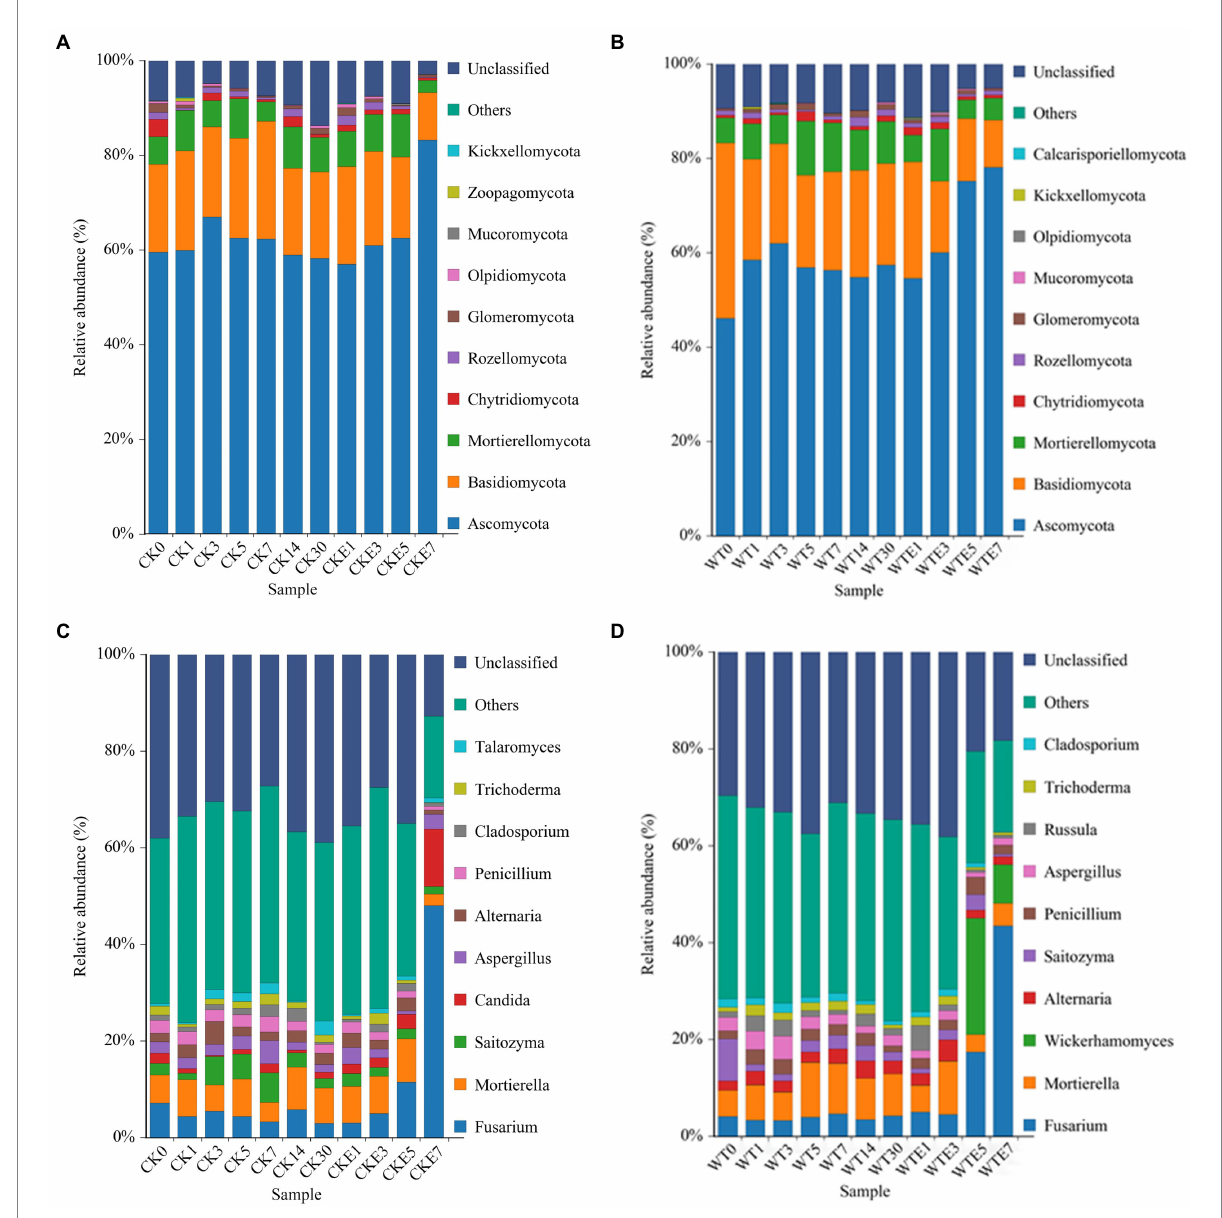
FIGURE 3 Relative abundance of fungal community during ensiling and aerobic exposure of King grass silage. (A,C) show the relative abundance at phylum and genus level for CK, respectively, while (B,D) show the relative abundance at phylum and genus level for WT, respectively. CK, unwilted silage; CKE, unwilted silage aerobic exposure; WT, wilting silage; WTE, wilting silage aerobic exposure; Arabic numerals indicate the time of